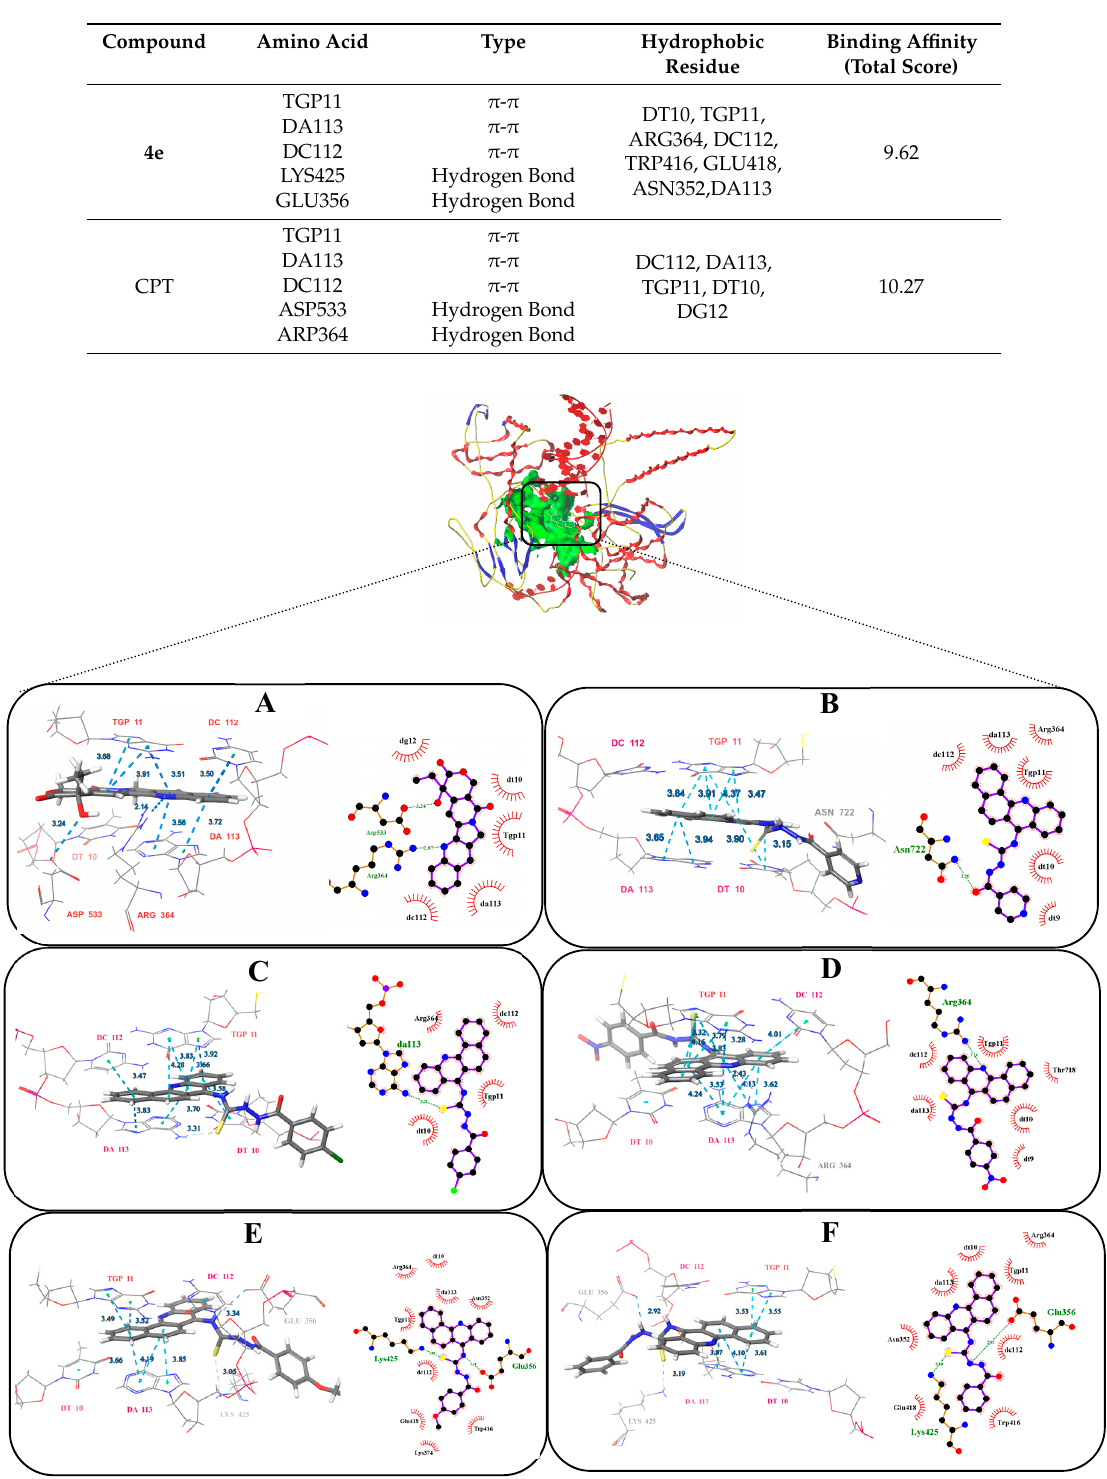
Figure 4. The best pose of the binding mode of compounds with DNA-Topo I complex (PDB:1T8I). ( A : CPT , B : 4a , C : 4b , D : 4c , E : 4d F : 4e ).